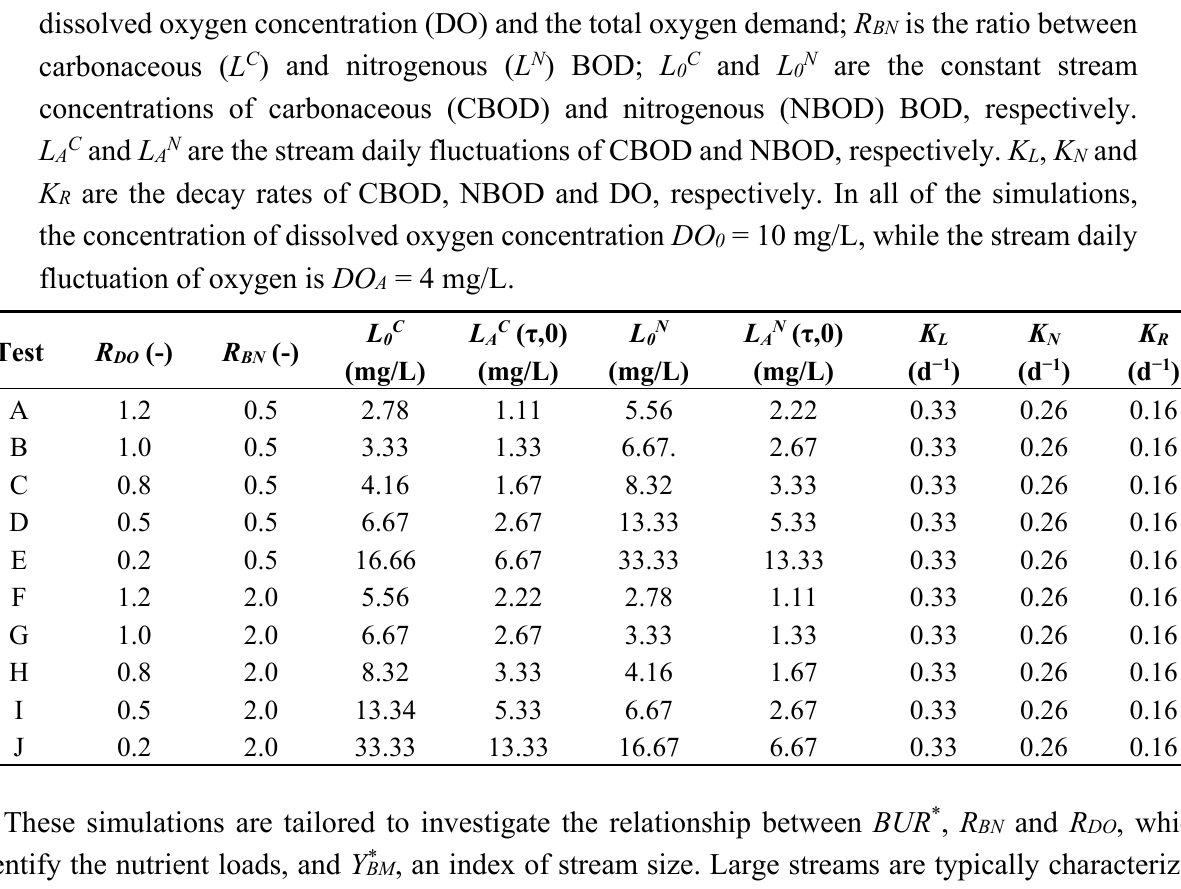
Table 2. Biogeochemical parameters used in the simulations. R DO is the ratio between dissolved oxygen concentration (DO) and the total oxygen demand; R BN is the ratio between carbonaceous ( L C ) and nitrogenous ( L N ) BOD; L 0C and L 0N are the constant stream concentrations of carbonaceous (CBOD) and nitrogenous (NBOD) BOD,